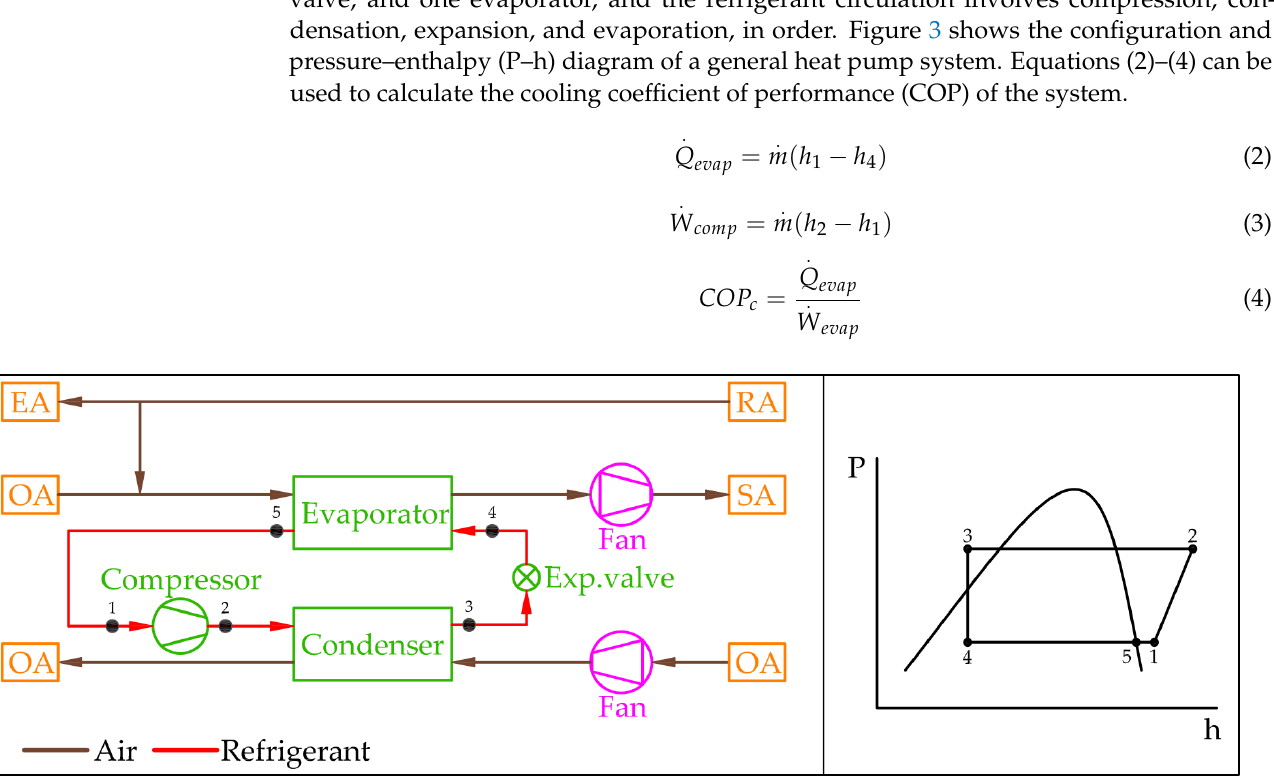
Table 1. Input conditions for cycle analysis.